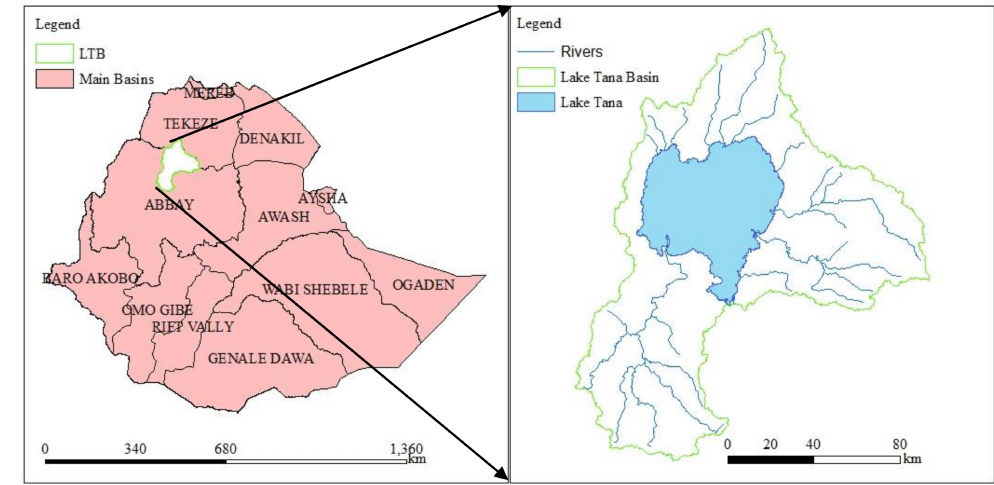
Figure 1. Location of Lake Tana Basin in